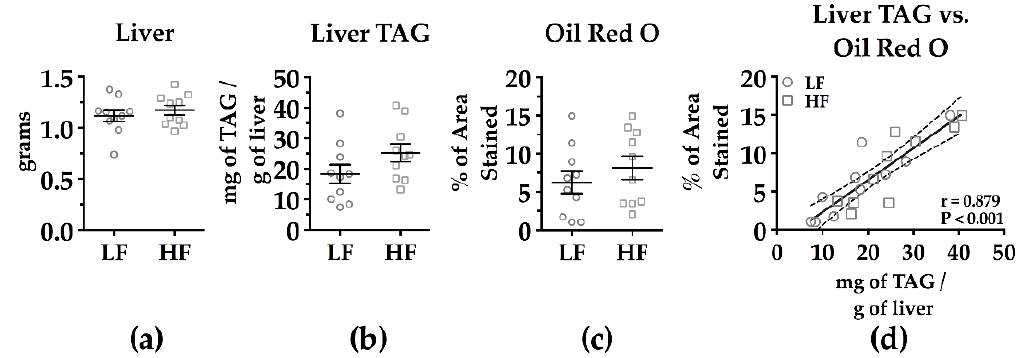
Figure 5. Liver mass ( a ); liver TAG content ( b ); percentage of area stained by Oil Red O ( c ); and the correlation between liver TAG and Oil Red O staining ( d ) in male C57BL/6J mice fed a low-fat (LF) or high-fat (HF) diet for 7 weeks prior to assessment. Mice were fasted 5–6 h prior to collection of the livers. See Figure S1 for representative Oil Red O images for each mouse. Pearson r is displayed. Mean ± SEM. LF n = 10; HF n = 10.